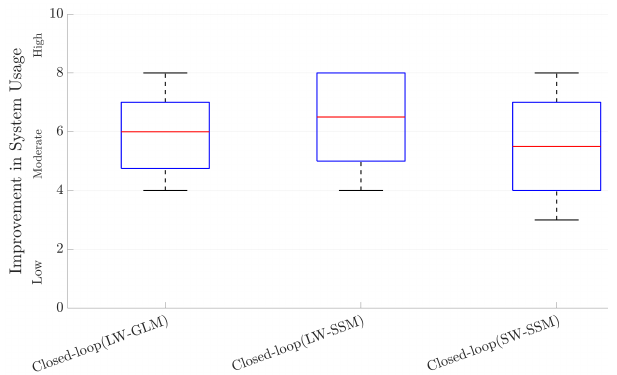
Figure 10. Subjective improvement in system usage for the closed-loop AAD system when using the LW–GLM, LW–SSM, and SW–SSM